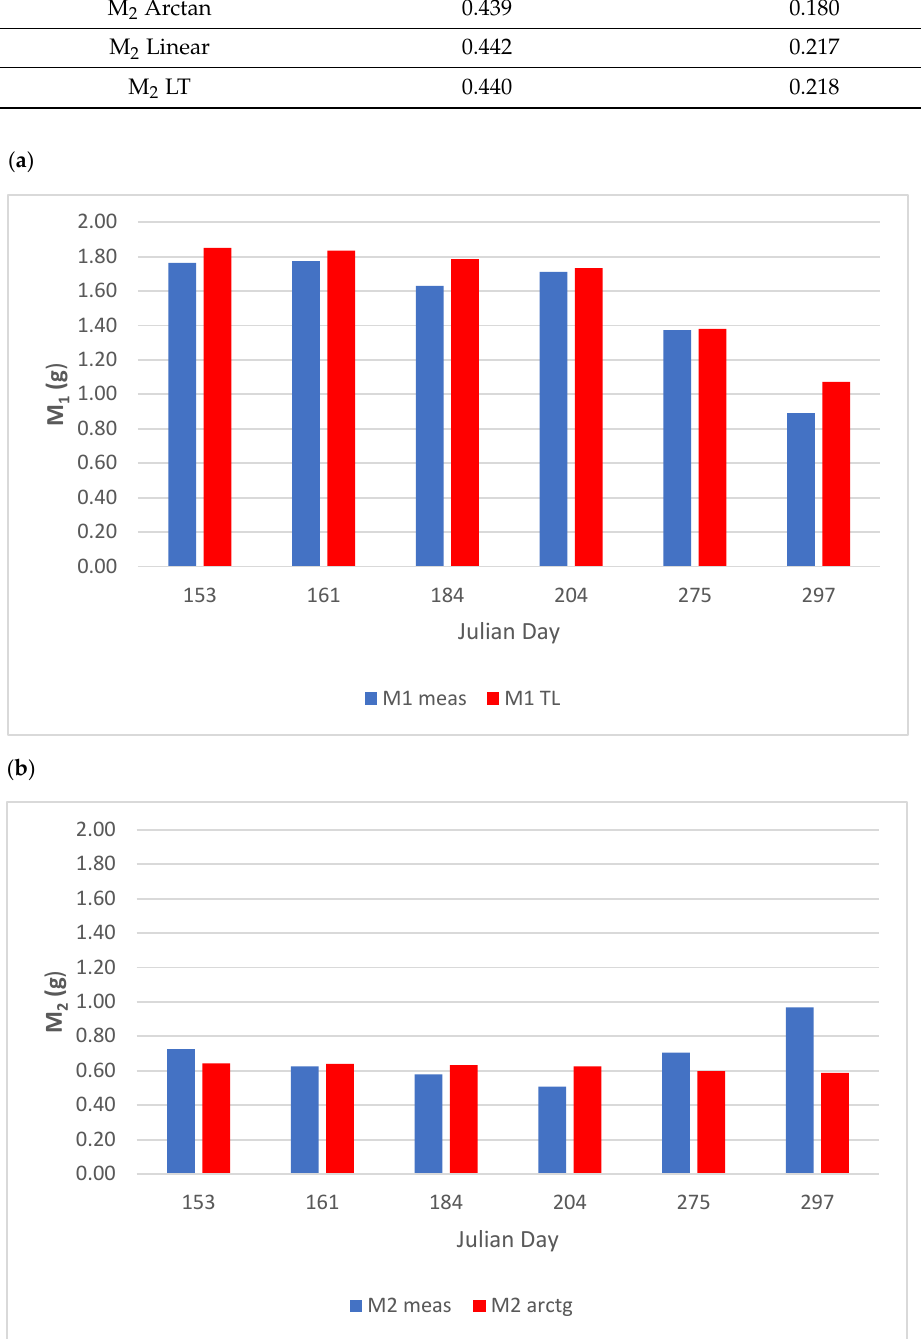
Figure 7. Trends of the real and simulated decomposition for M 1 ( a ) and M 2 ( b ) compared to the respective M pools derived by simulations with the appropriate CDI.